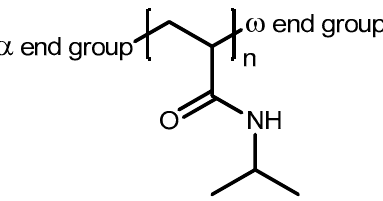
Figure 1 . End groups in a PNIPAAm homopolymer chain. Figure 1. End groups in a PNIPAAm homopolymer